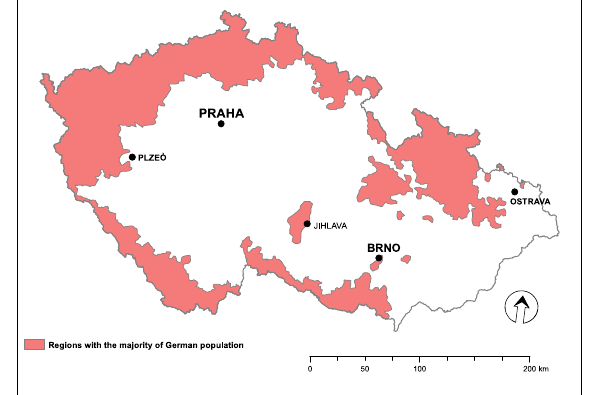
Fig. 1. Czech regions with the majority of German population in